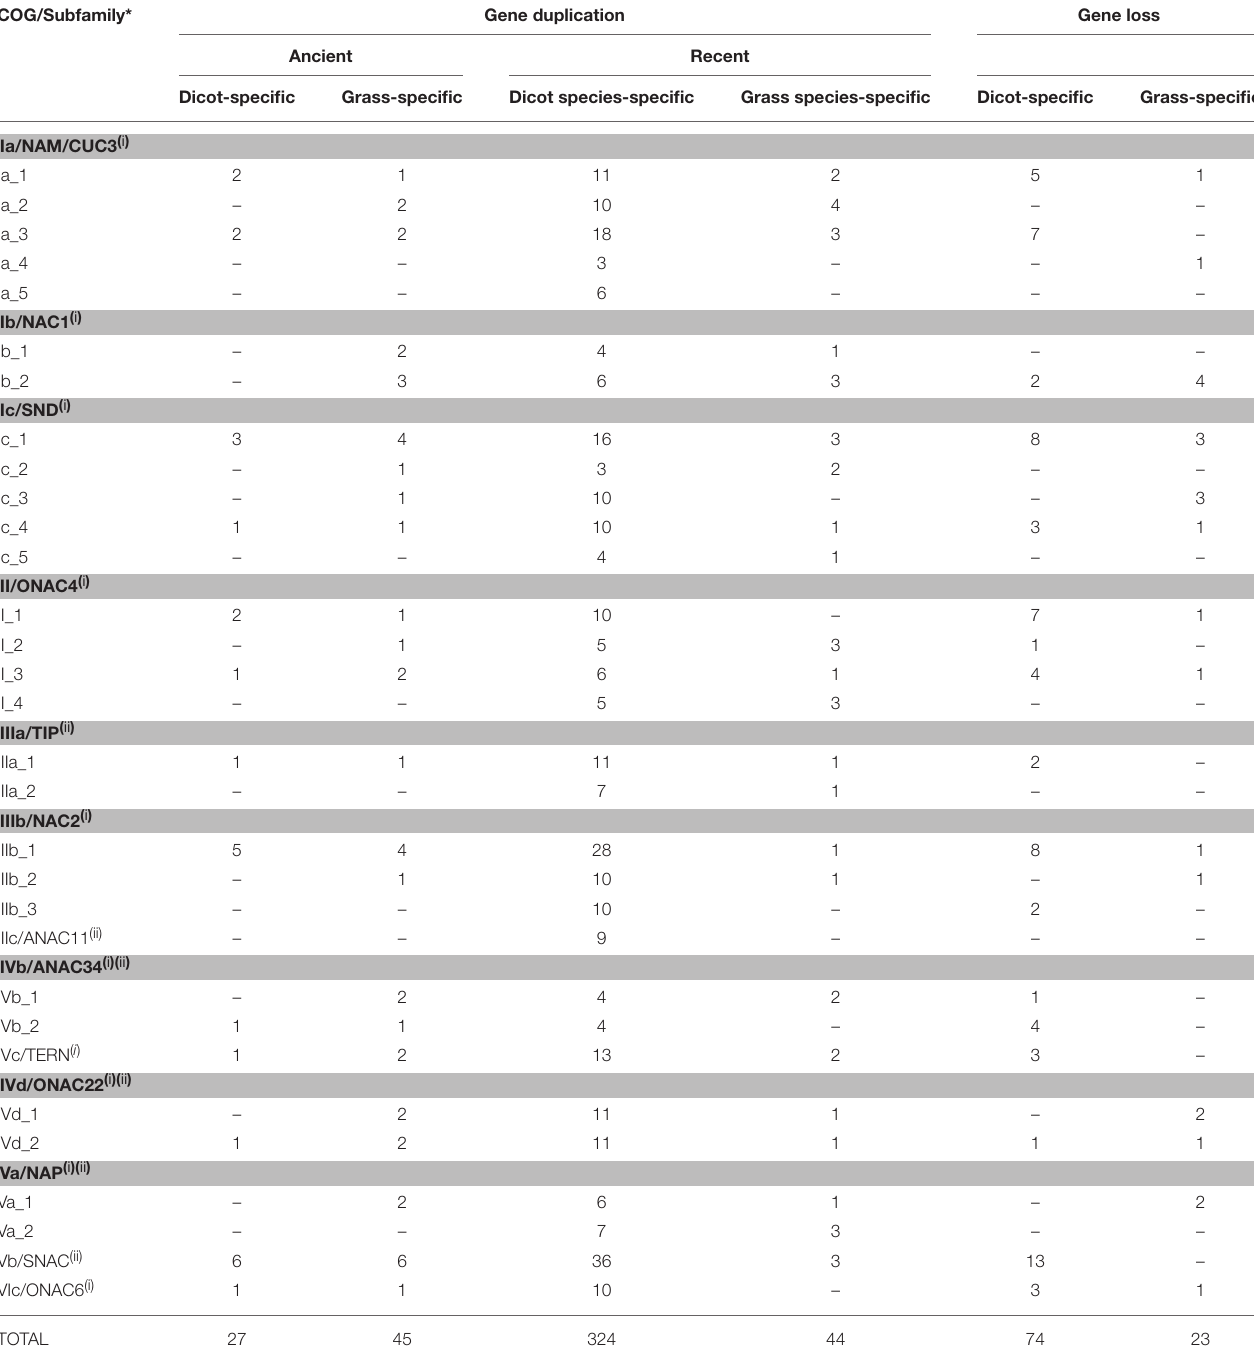
TABLE 1 | Gene duplication and loss in each of the NAC TFs COGs/subfamilies. COG/Subfamily* Gene